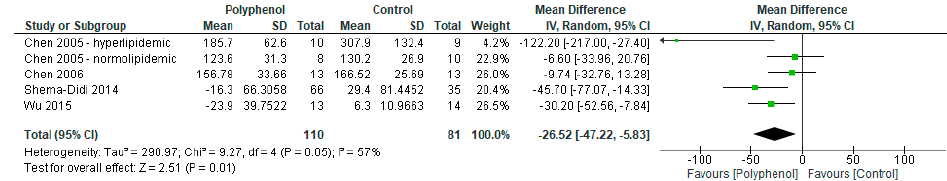
Figure 6. Forest plot of polyphenol-rich interventions on triglyceride levels.